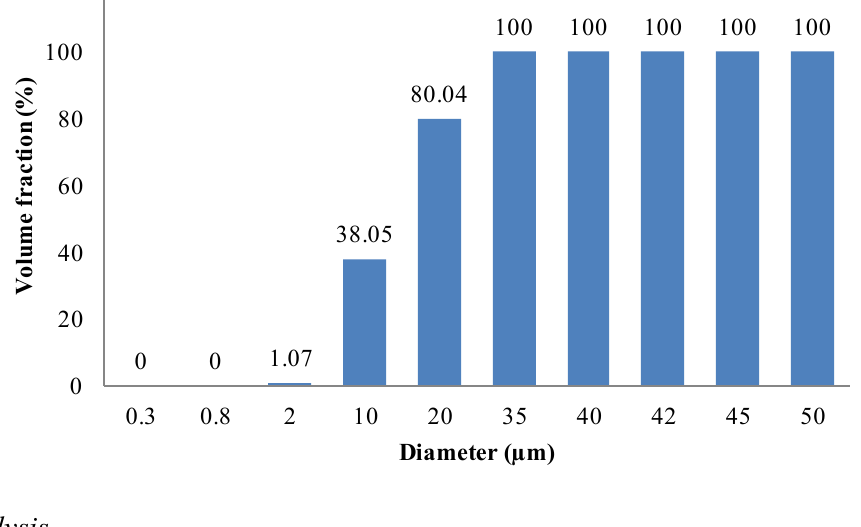
Figure 4. The volume of different particle diameter distribution.